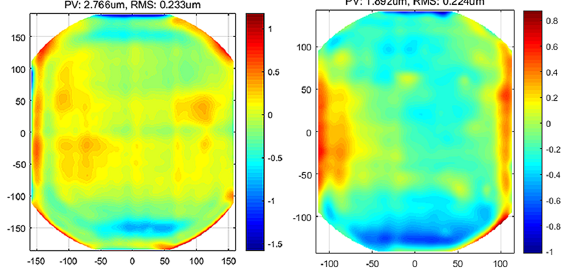
Fig. 2. Surface shape error after grinding. (Left: primary mirror, PV 2.8um. Right: tertiary mirror, PV 1.9um)